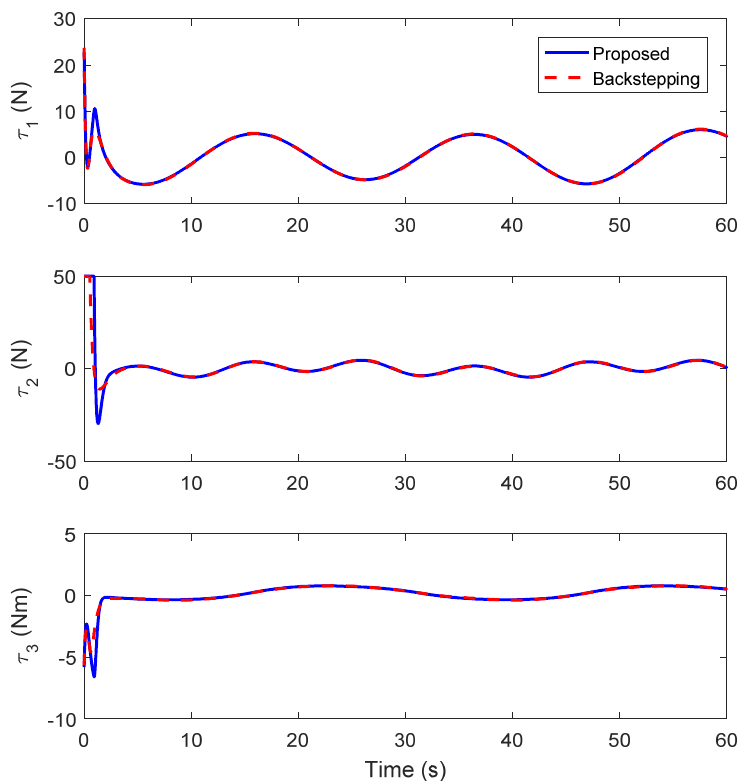
Figure 8. Pro fi le of the control inputs (Case 1).